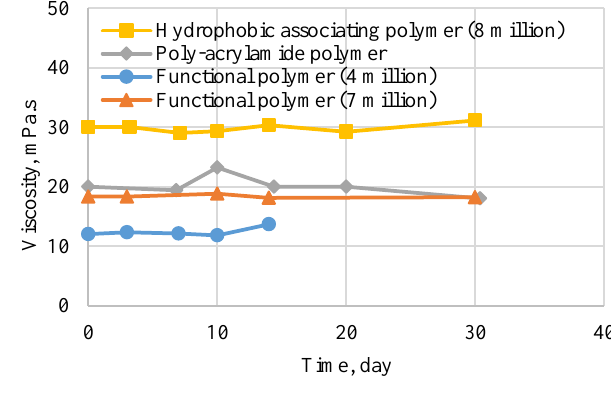
Figure 3—Comparison of stability between hydrophobic associating polymer and other polymers.